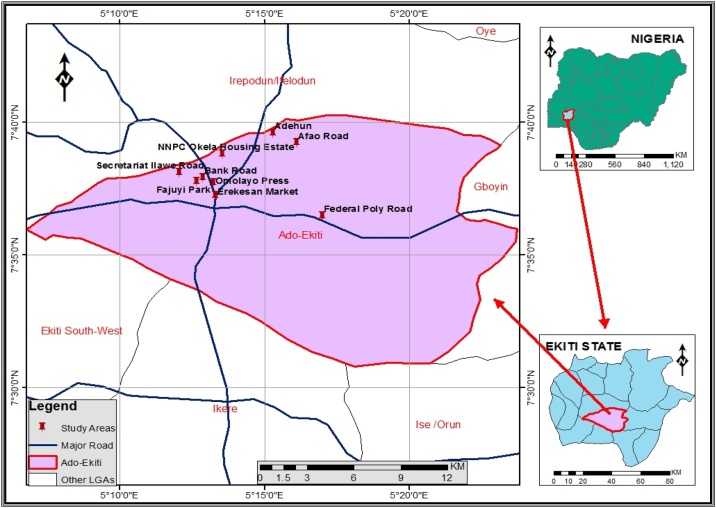
Map of Ado – Ekiti showing the coordinates of sampling sites.